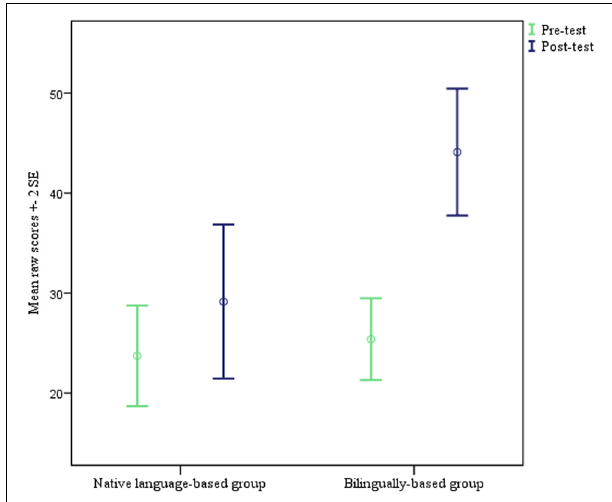
FIGURE 1 | PPVT-IV receptive vocabulary development, pre-test to post-test.